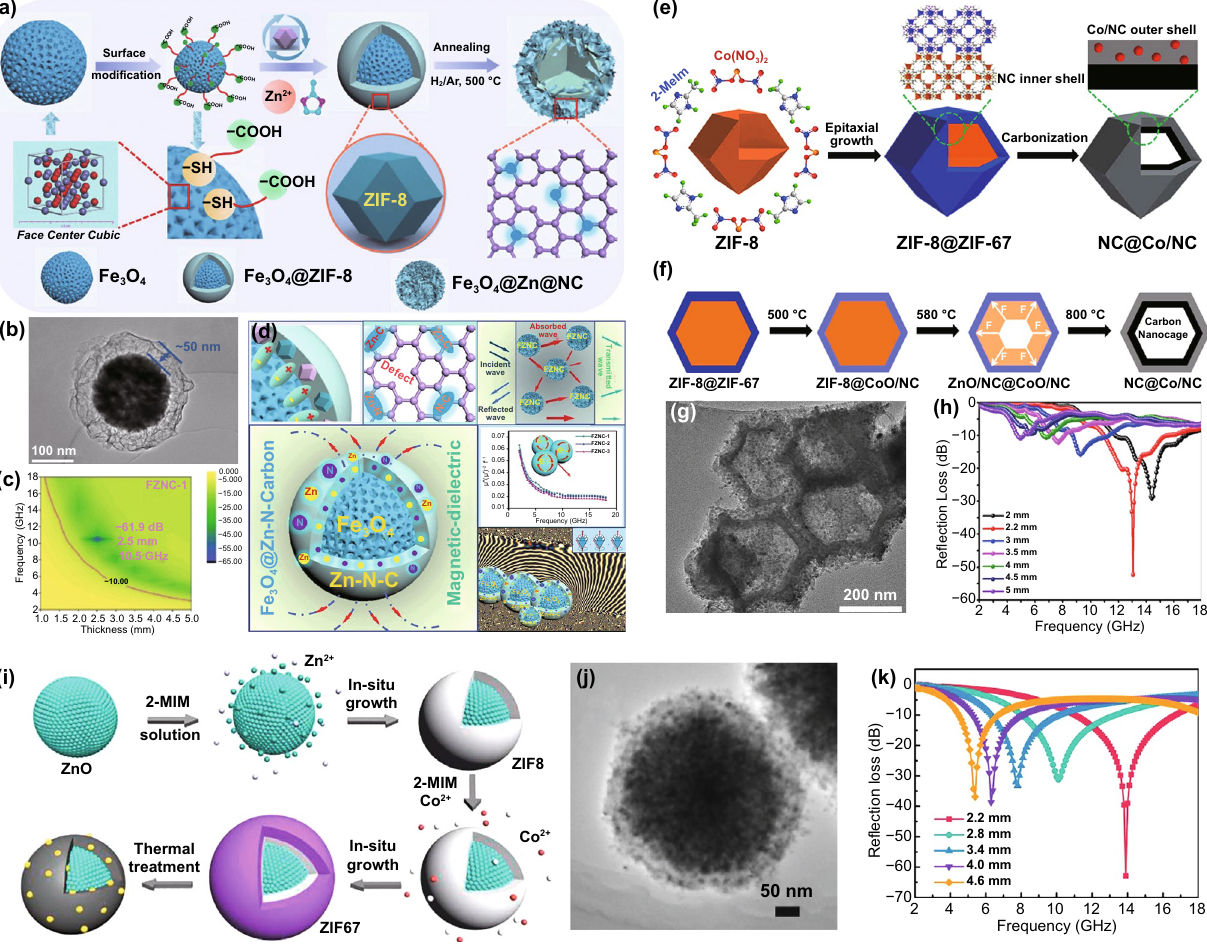
Fig. 18 a Diagrammatic sketch of the synthesis, b TEM image, c 2D RL-f mapping and d schematic diagram of MA mechanism of Fe 3 O 4 @ Zn-N-Carbon. Reprinted with permission from Ref. [168]. e Schematic illustration of formation process, f synthetic mechanism, g TEM image and h RL-curves of NC@Co/NC carbon nanocages. Reprinted with permission from Ref. [172]. i Schematic illustration of the synthesis, j TEM image and k RL-curves of ZnO@carbon/Co 3 ZnC. Reprinted with permission from Ref.